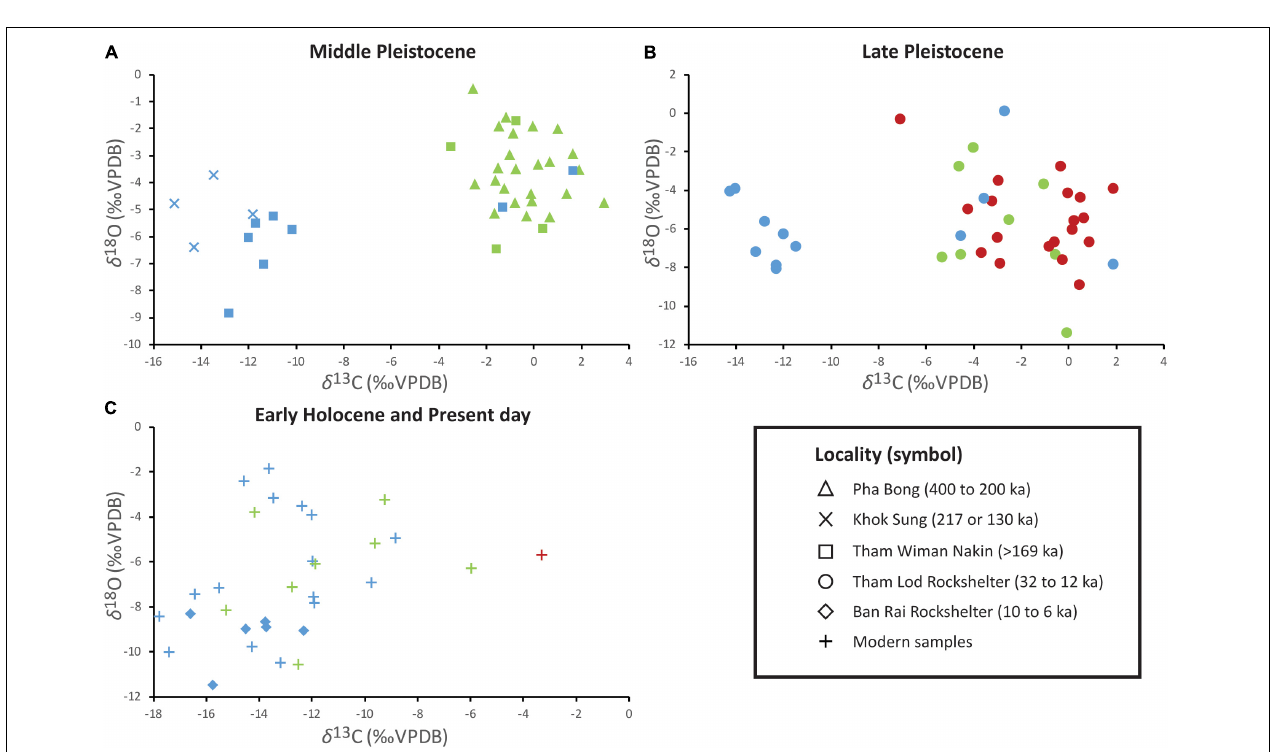
FIGURE 3 | A scatter diagram of enamel δ 13 C and δ 18 O values of three caprine species: Naemorhedus goral (green), Naemorhedus griseus (red), and Capricornis sumatraensis (blue), from (A) the Middle Pleistocene of Pha Bong, Khok Sung, and Tham Wiman Nakin, (B) the Late Pleistocene of Tham Lod Rockshelter, and (C) the Early Holocene of Ban Rai Rockshelter as well as the modern representatives. Previous isotope data of N . goral from Pha Bong (16 samples analyzed by Bocherens et al., 2017) and C . sumatraensis from Khok Sung (one sample analyzed by Suraprasit et al., 2018) are plotted together in the diagram.